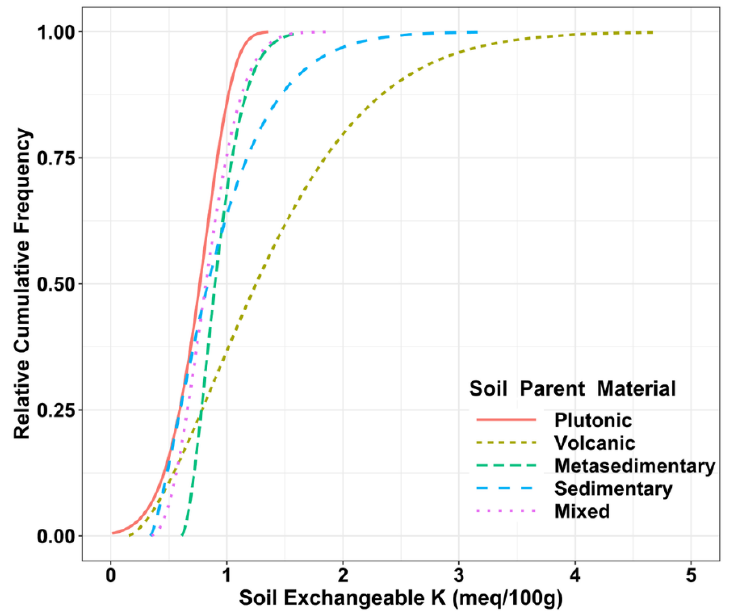
Figure 3. Soil exchangeable potassium cumulative distributions for different bedrock soil parent materials in the Inland Northwest, USA.